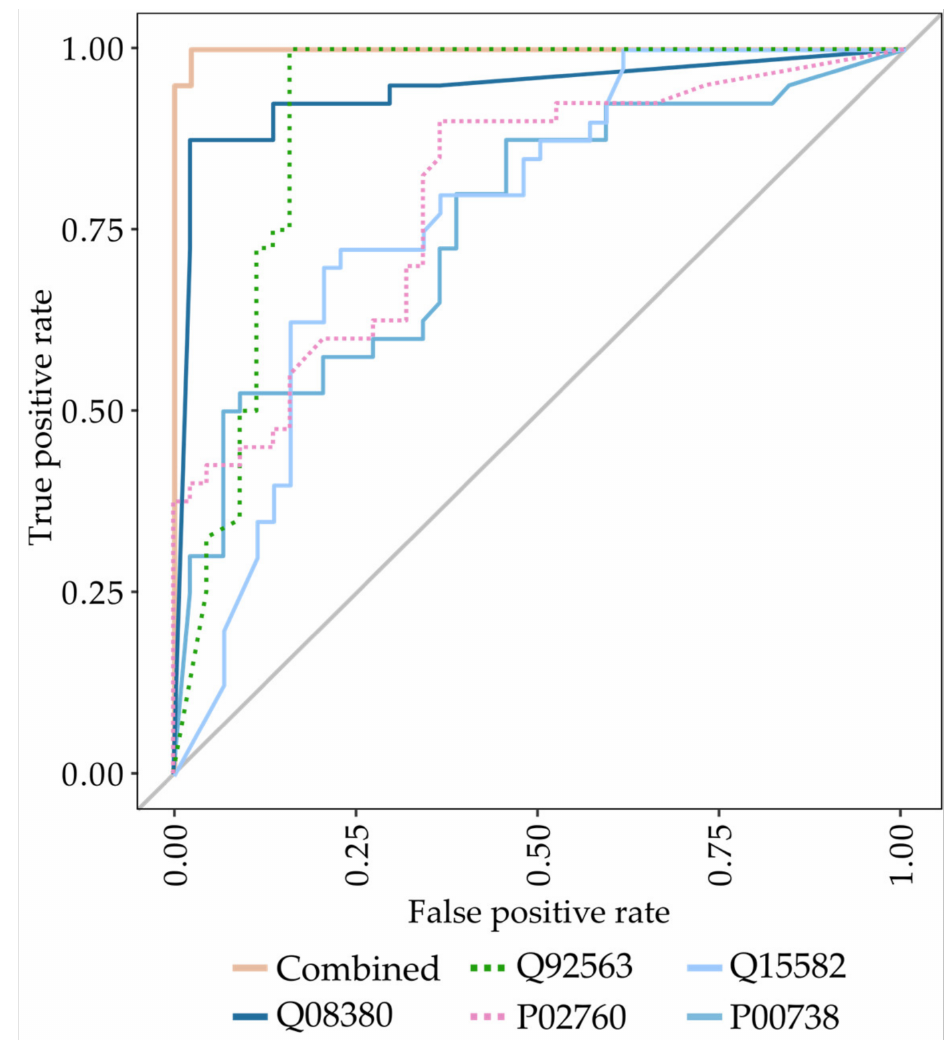
Figure 1. ROC analysis of the combined 5-protein classifier with individual curves for each constituent protein. Q08390: galectin-3-binding protein; Q92563: testican-2; P02760: protein AMBP; Q15582: Beta ig-h3; P00738: